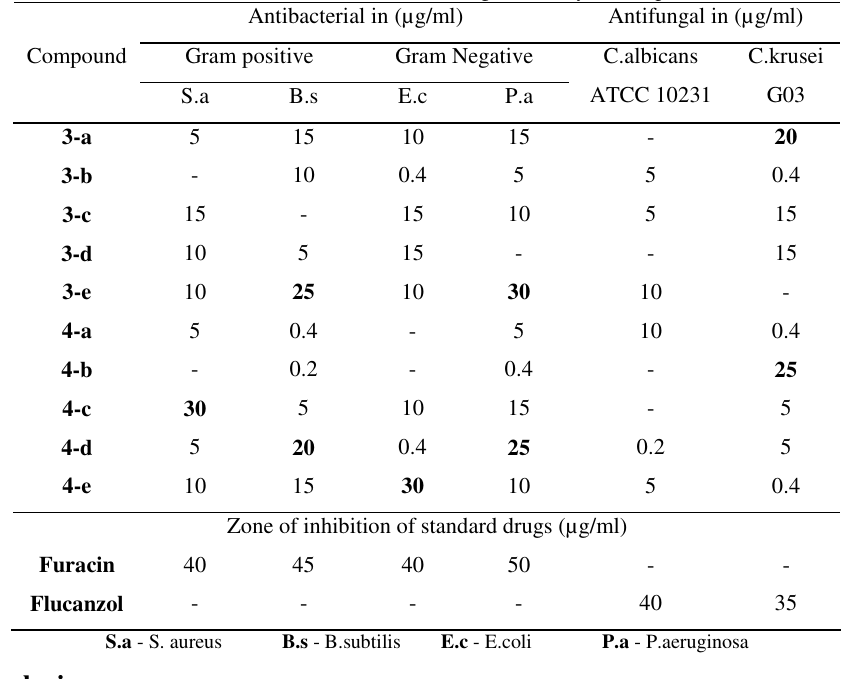
Table-3. In vitro Antibacterial and Antifungal Activity of compound